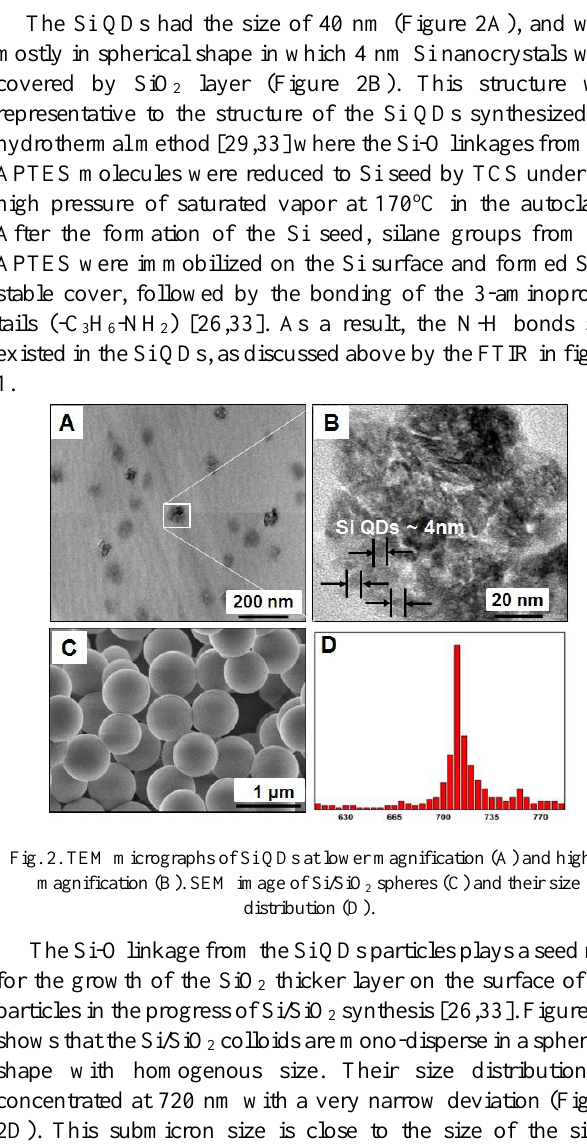
high pressure of saturated vapor at 170 o C in the autoclave.